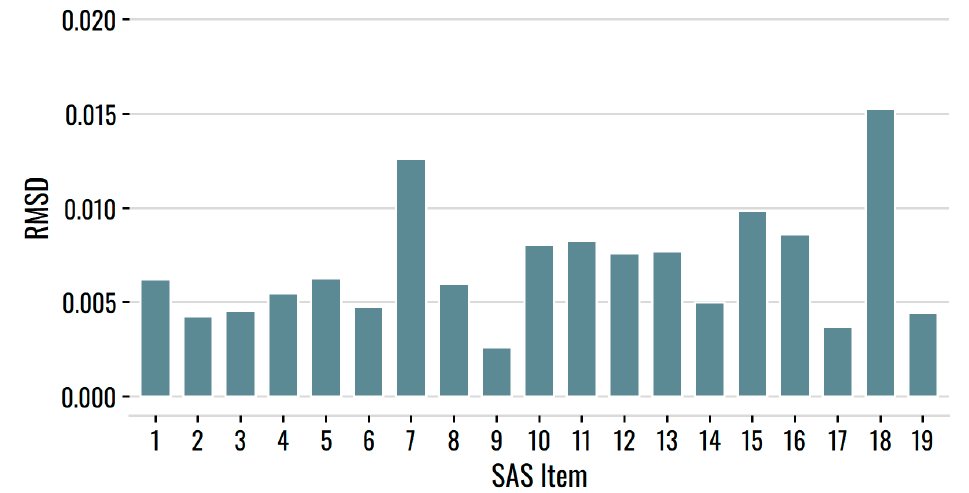
Figure 5. RMSD item fit for the SAS items.